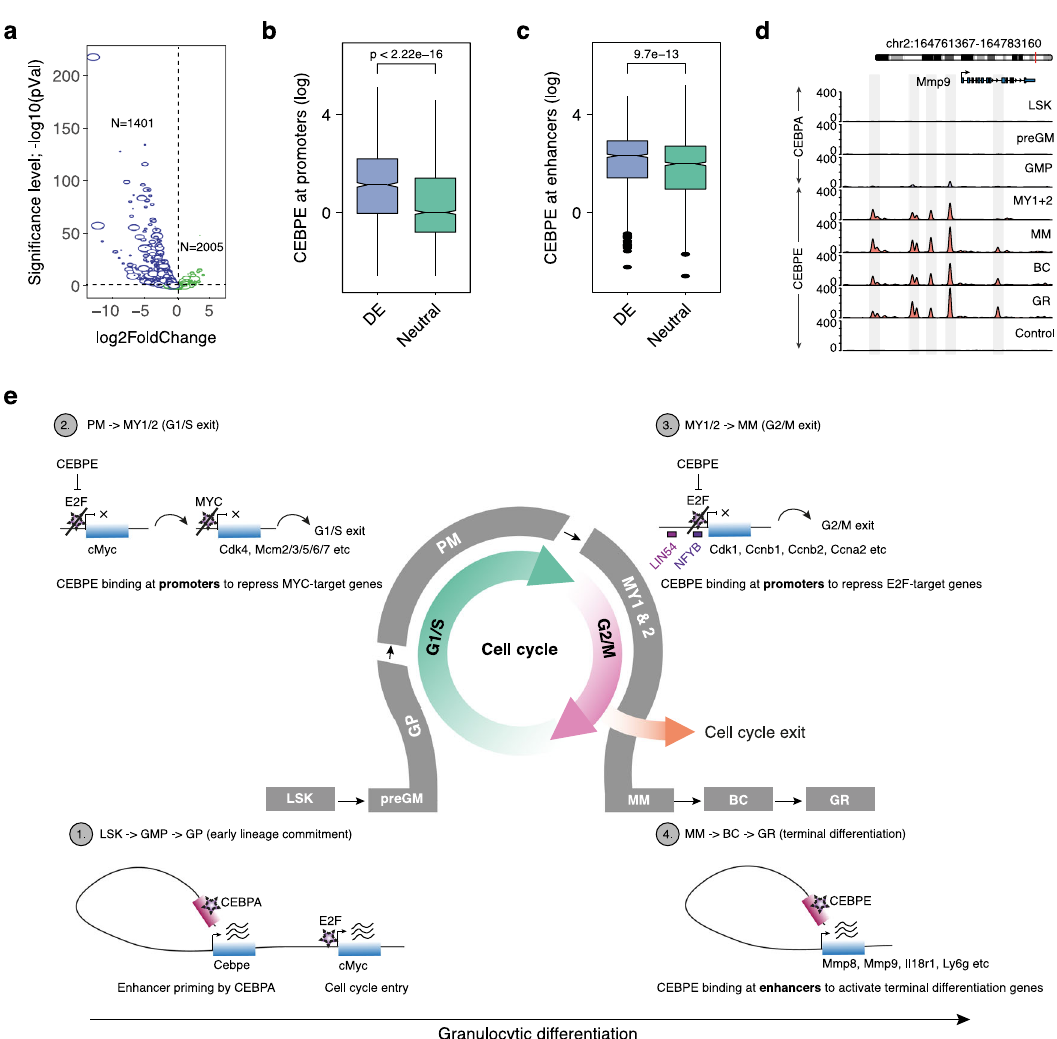
Fig. 7 CEBPE promotes terminal granulocytic differentiation through enhancer-mediated regulation of gene expression. a Volcano plot showing log2- fold-change in the expression of late granulocytic differentiation genes (cluster C(GR)) differentially expressed (DE) in Cebpe KO vs. Cebpe WT mice. Approximately 41% of late granulocytic differentiation genes are downregulated in Cebpe KO mice, whereas the residual genes exhibit similar expression. b , c Genes downregulated in Cebpe KO mice ( N = 1401) demonstrate signi fi cantly higher levels of CEBPE binding, both at promoters ( b ) and enhancers ( c ), in comparison to genes whose expression remains neutral ( N = 2005) (center line, median; box limits, upper and lower quartiles; whiskers, 1.5x interquartile range; points, outliers) (Wilcoxon test, one-sided). d Genome browser view of the tertiary granule protein — matrix metallopeptidase 9 (Mmp9) which is markedly upregulated during late granulocytic differentiation (cluster C (GR), Fig. 2a) and has multiple CEBPE binding sites. e Uni fi ed model depicting how the tissue-speci fi c TFs, CEBPA, and CEBPE, coordinate sequential lineage-speci fi cation (step 1), growth arrest (steps 2 and 3), and lineage-determination (step 4) during early and terminal granulocytic differentiation. Source data are provided as a Source Data fi